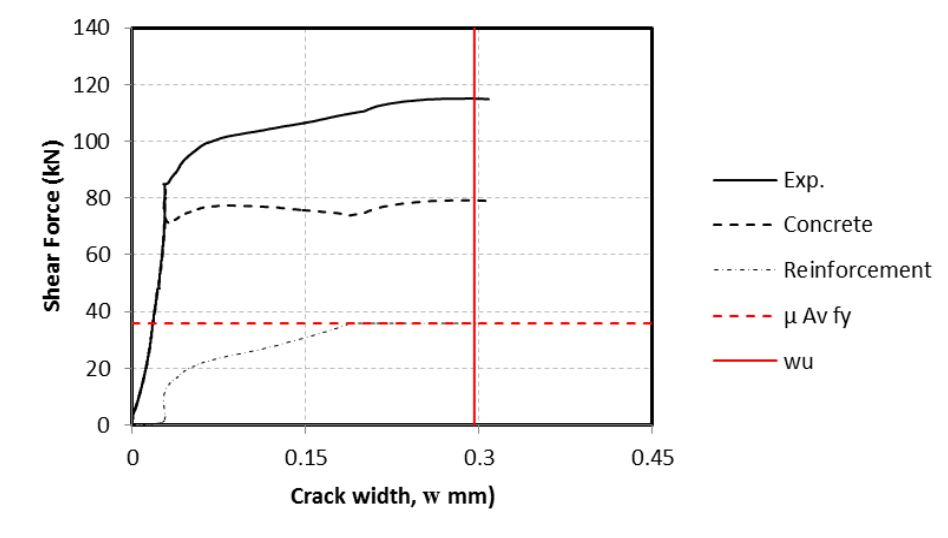
Figure 10. Experimental and theoretical shear strengths of SCN-A specimen.